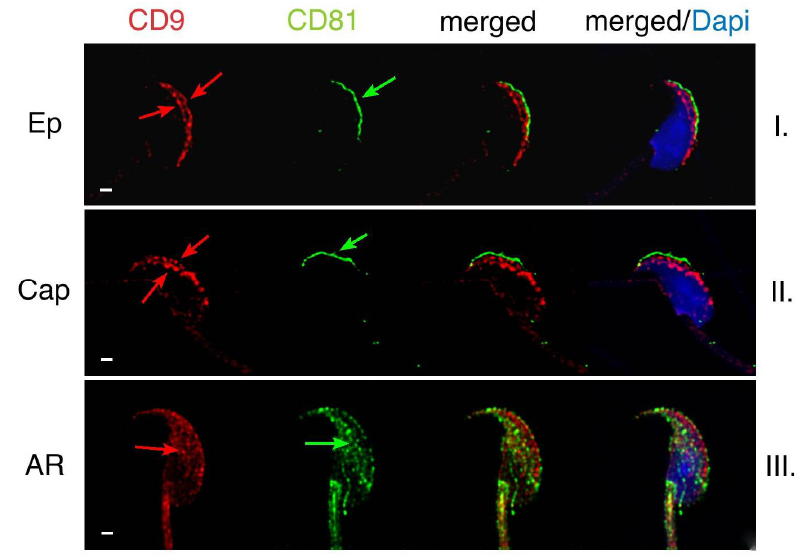
Figure 1. Dynamics of CD9 and CD81 and changes in their mutual localization in mouse sperm captured by confocal microscopy. ( I ) In freshly released epididymal mouse sperm, CD9 (red) is locked over the acrosome vesicle in both of its membrane compartment—inner and outer acrosome membrane (red arrows) and CD81 (green) is present in plasma membrane over the apical acrosome (green arrow). ( II ) During capacitation no changes in localization of both proteins occur, see both red and green arrows. ( III ) After finishing of AR, plasma membrane covering acrosome apical area and outer acrosomal membrane are lost. However, both CD9 and CD81 are still detectable. CD9 and CD81 are relocated in inner acrosomal membrane and in plasma membrane of equatorial segment (red and green arrows). They start in mutual contact. DAPI (blue). Scale bar represents 1 μm.